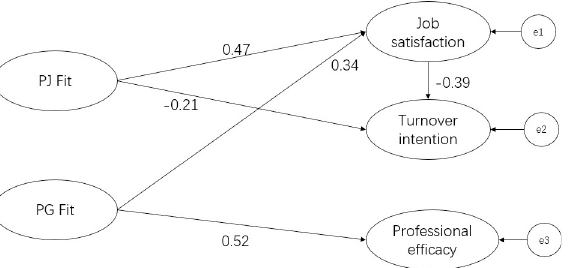
Fig 1. Structural equation model diagram produced using AMOS software. Observed variables are omitted from the graph. The model contains latent variables and e1, e2, and e3 are error items. The arrow indicates the regression path from the independent variables to the dependent variables.